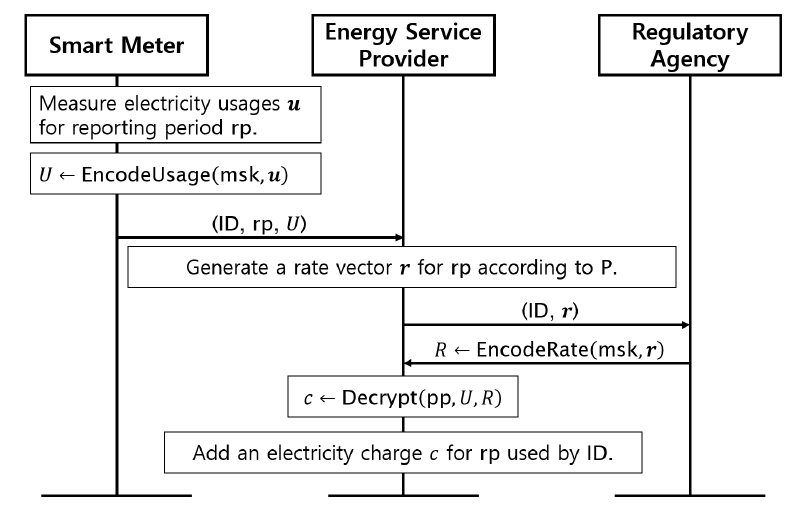
Figure 3. Reporting stage of our